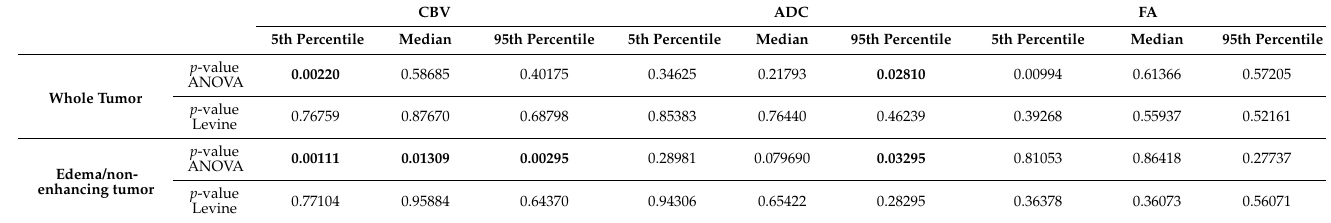
Table 3. Results of one-way ANOVA analysis between the 5th percentile, median, and 95th percentile of cerebral blood volume (CBV), apparent diffusion coefficient (ADC), and fractional